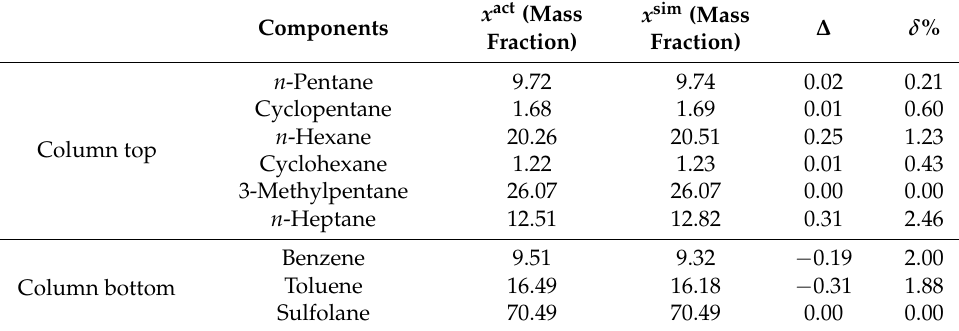
Table 6. Comparison of main process indexes of